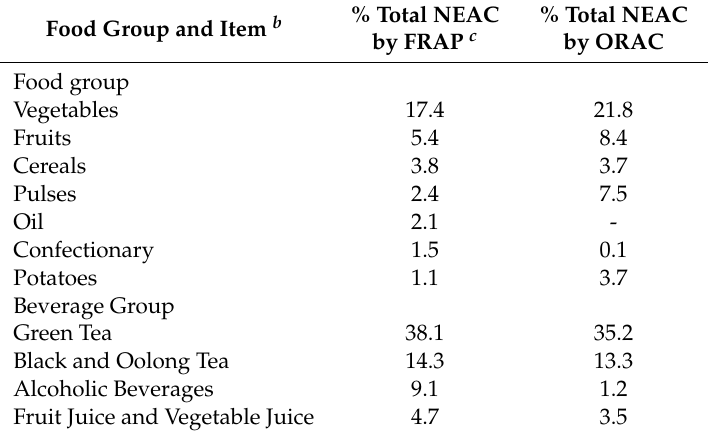
Table 1. The percentage contributions of the food and beverage items to dietary NEAC intake